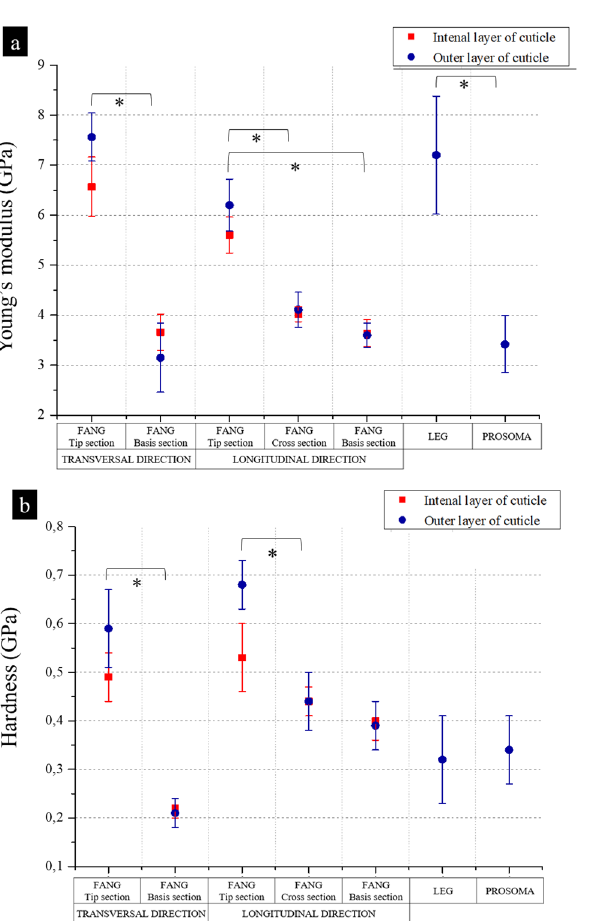
Figure 5. Values of the Young’s modulus ( a ) and hardness ( b ) in each analysed section of the spider. Stars indicate significant differences (p-value < 0.5) and are valid for both external and internal cuticle